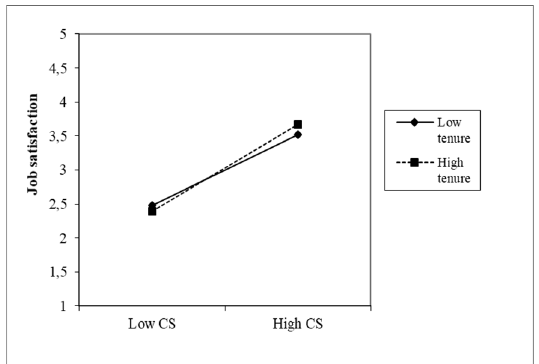
Figure 2. Moderating effect of management practice FLNMs on the CS–JS relationship.